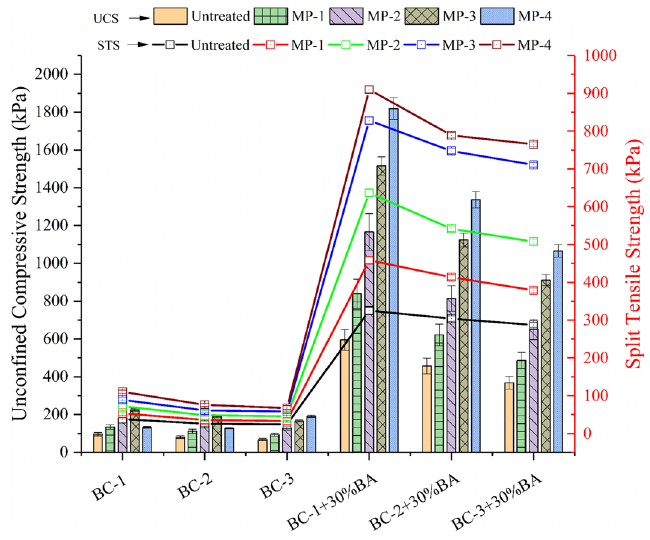
Figure 5. Effect of biostimulated MICP treatment on unconfined compressive strength and split tensile strength of the expansive